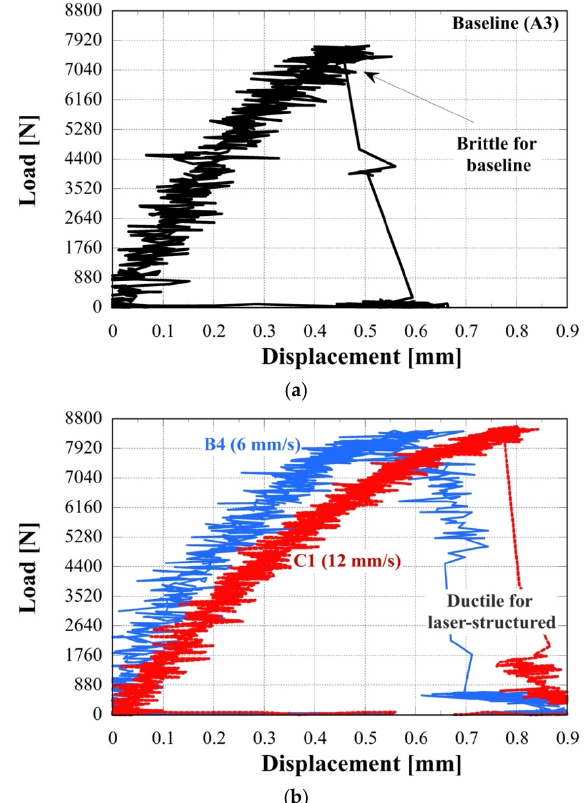
Figure 13. Load versus displacement variation during single-lap shear testing for ( a ): baseline specimen A3 and ( b ) laser-structured specimens B4 and C1 (6 and 12 mm/s raster speed, respectively). The results of the tensile shear testing are shown in Table 5. The results for specimen C4 exhibit a significant lower maximum loading, shear stress, and maximum displace- ment than the other samples. Table 5. Geometry, maximum loading, maximum shear stress, and displacement at maximum loading for the laser-struc- tured (raster method) and baseline specimens (A: Baseline: B: 6 mm/s; C: 12 mm/s).